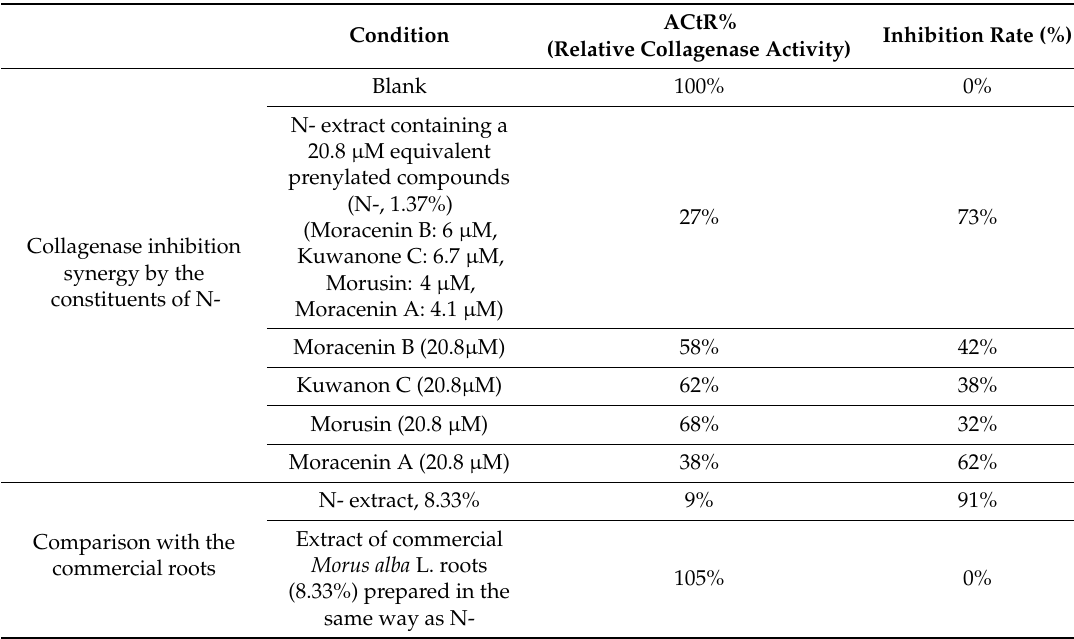
Table 2. Evaluation of collagenase inhibitory activity of N- extract and its prenylated compounds in comparison to a commercial extract of Morus alba L. roots using UHPLC technique.